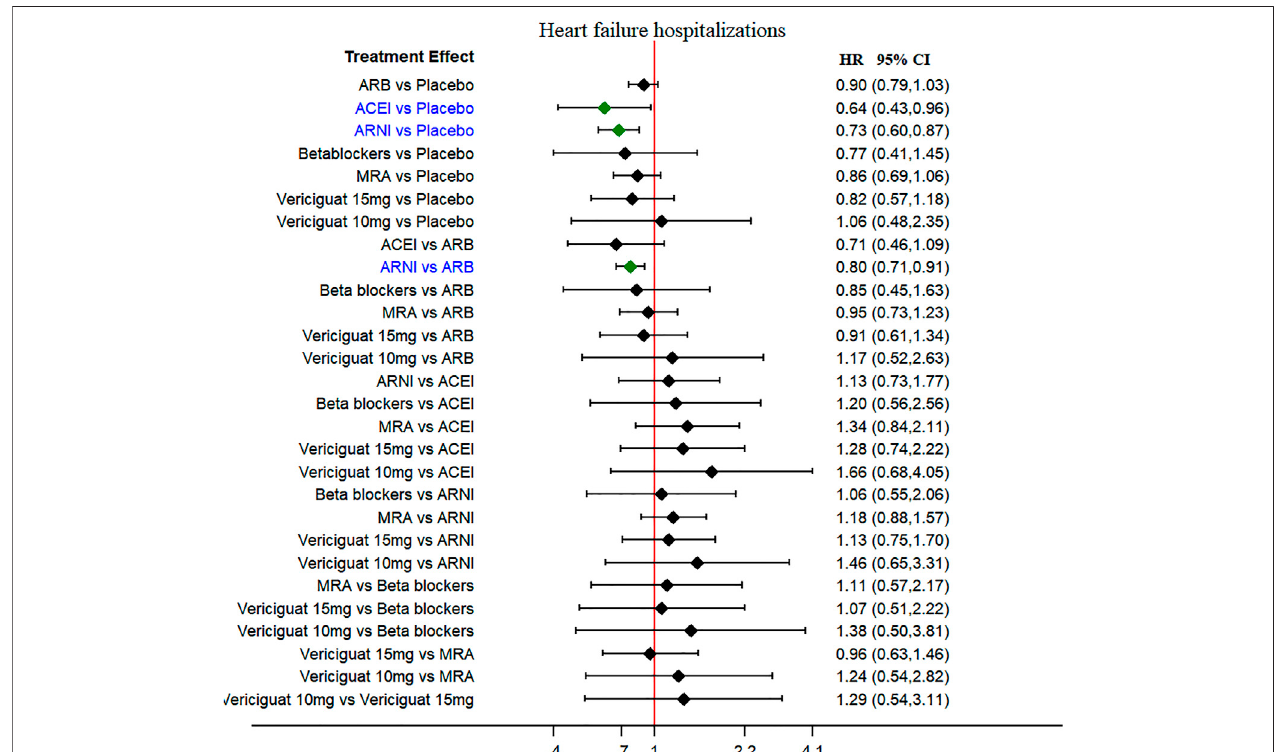
FIGURE 3 | All-cause mortality (primary outcome): Forest plot (estimates as hazard ratio) - All trials.